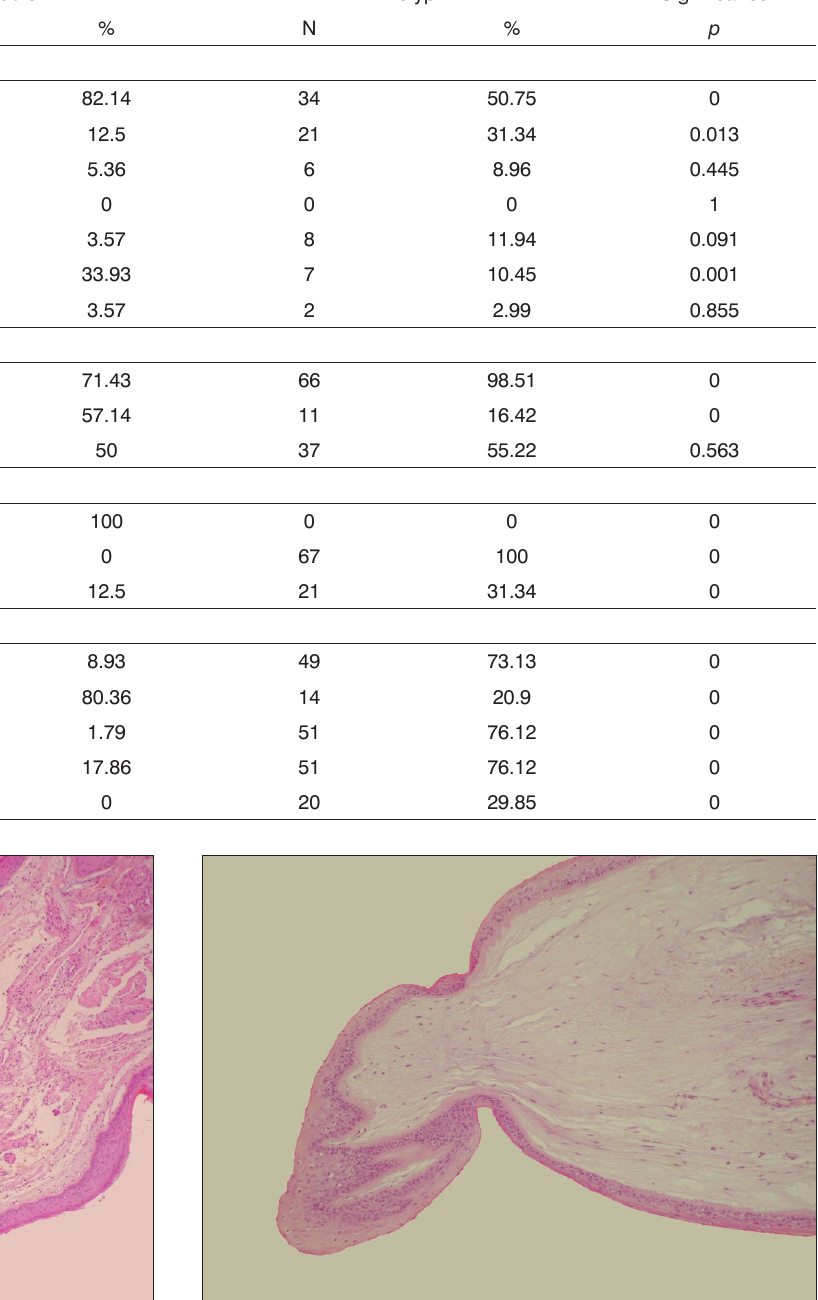
Table 4. Histopathological features of the vocal fold nodules and polyps stained with HE, Gomori trichrome and PAS. Characteristics